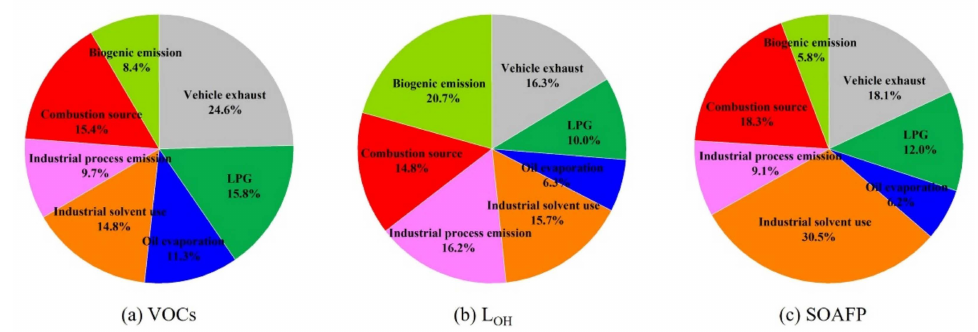
Figure 8. Source contributions of ( a ) VOCs, ( b ) L OH , and ( c )